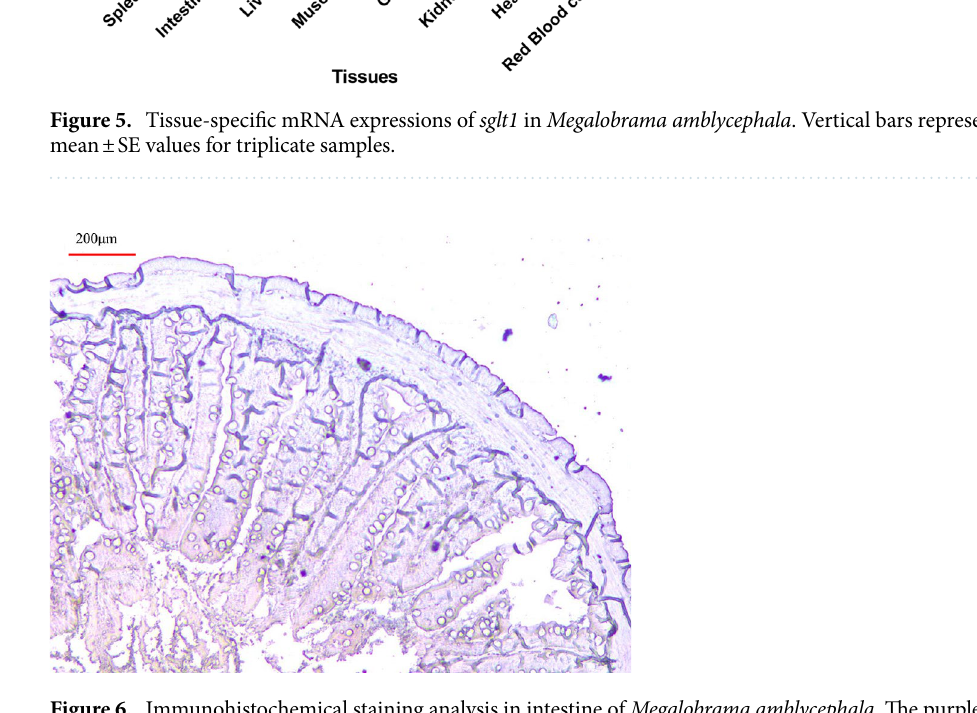
Figure 6. Immunohistochemical staining analysis in intestine of Megalobrama amblycephala. The purple signal is our target